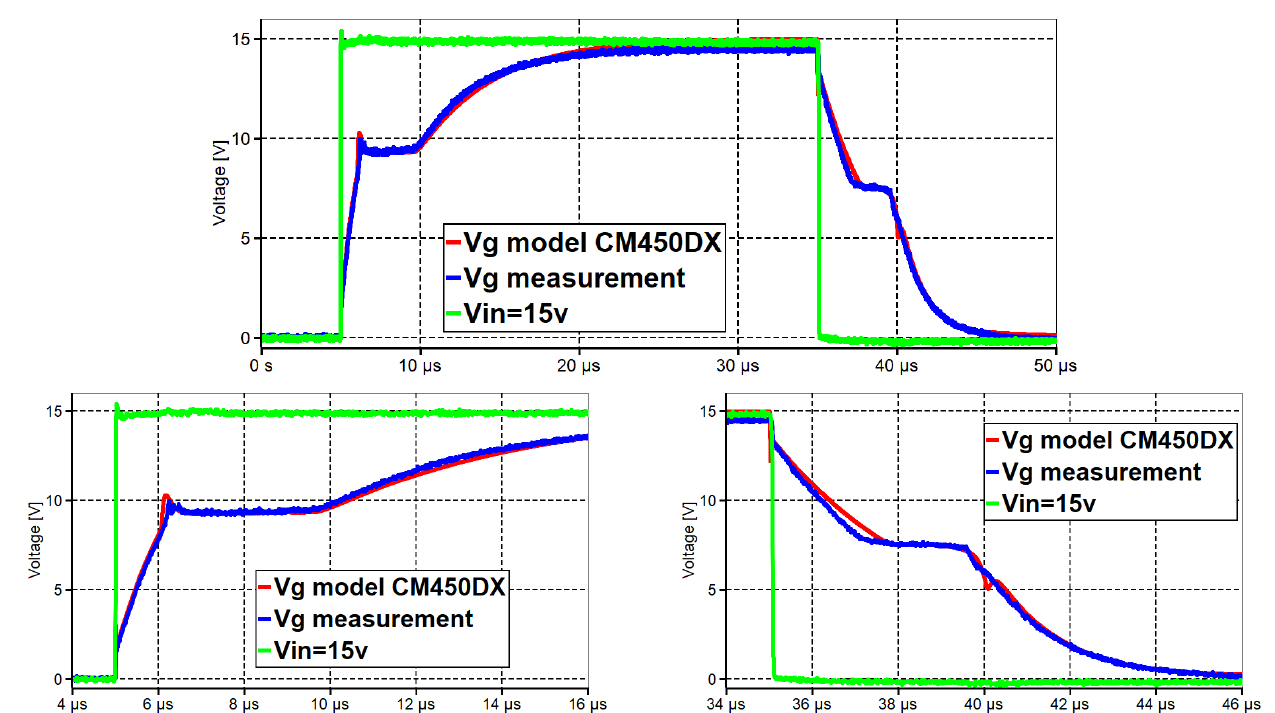
Figure 13. Simulated and measured gate voltages for the Mitsubishi Electric CM450DX-24S module.